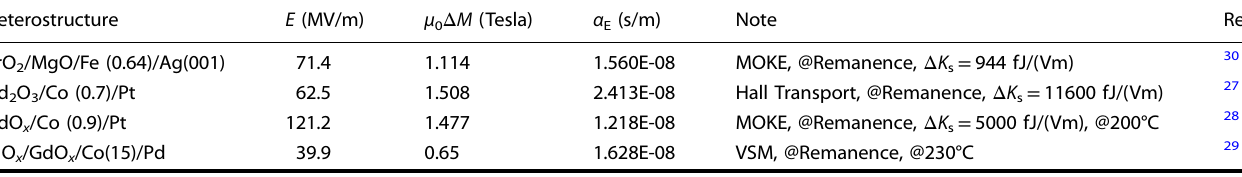
Table 3b. Converse magnetoelectric coupling mediated by electrically modulated degree of interfacial oxidation, also known as ‘ magneto-ionic ’ control of magnetism according to Beach et al. 28